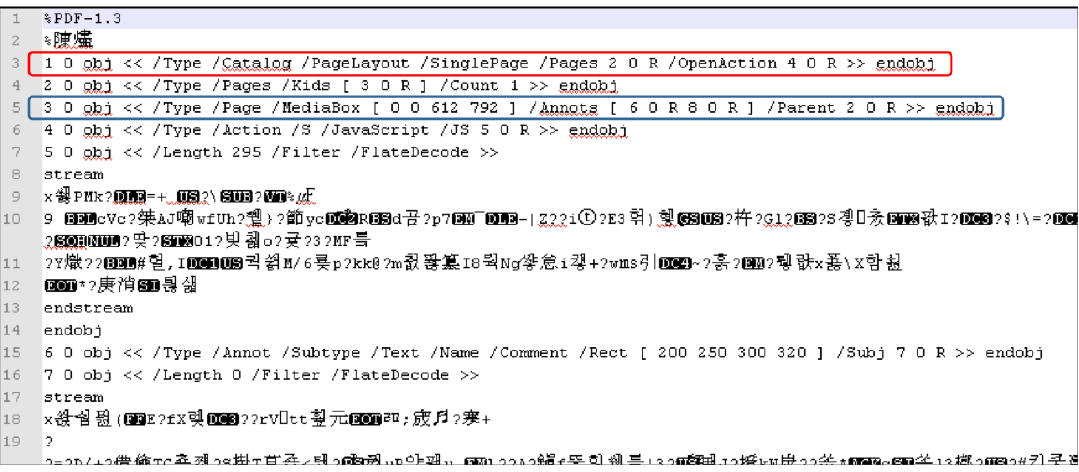
Figure 4. A snapshot of the body.